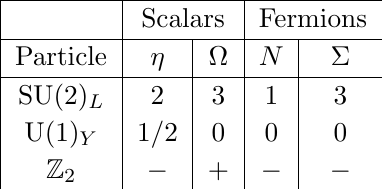
Z U(1) Y 2 (cid:2) (cid:2)